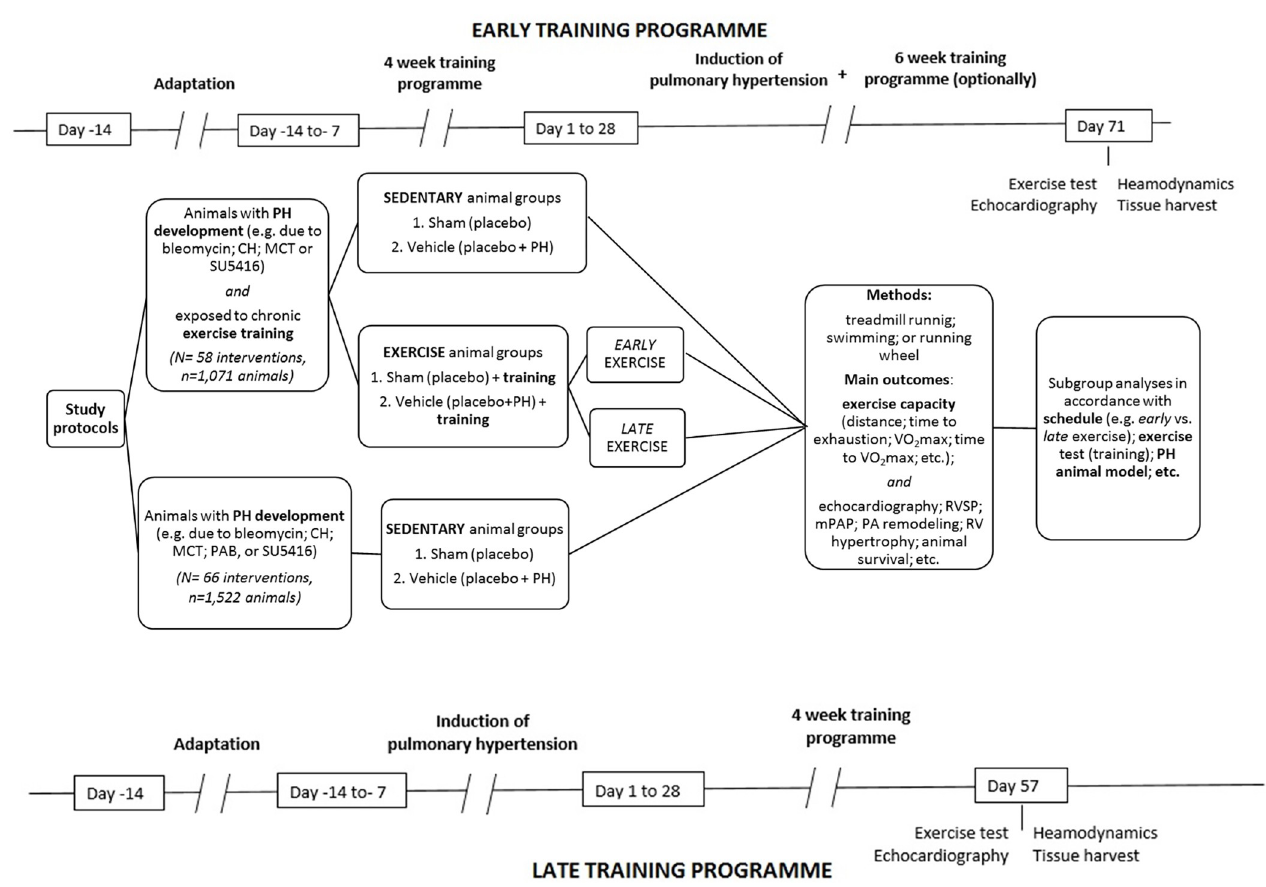
Fig 2. The study flow according to the purpose (exercise training, and/or assessment of animal capacity), some methodological items that characterized the analyzed experimental protocols on pulmonary hypertension, and an example scheme for study protocols for early and late training. CH–chronic hypoxia; MCT–monocrotaline; PA–pulmonary artery; PH–pulmonary hypertension; PAB–pulmonary artery banding; RV–right ventricle; RVSP–right ventricle systolic pressure; SU5415 –Sugen 5416; VO 2 max–maximal oxygen